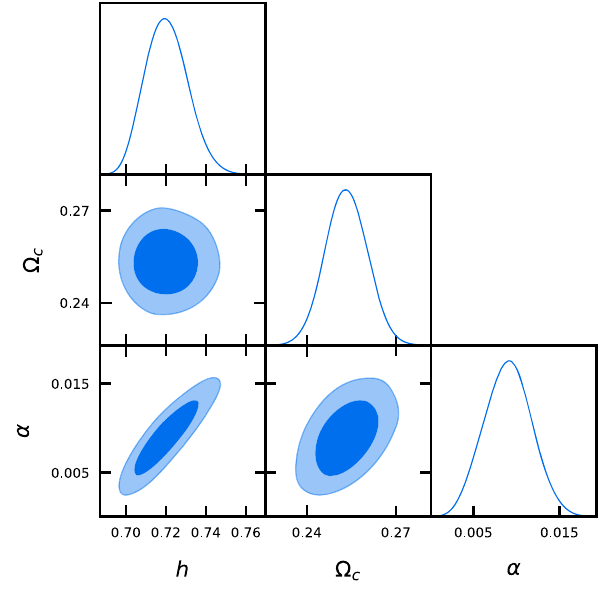
Fig. 9 Contour plots for the model Γ 1 T , 1 σ and 2 σ confidence levels are